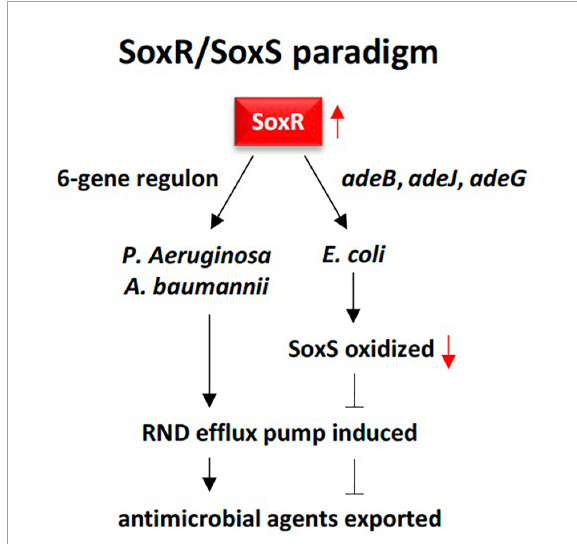
FIGURE8 Demonstration of the RND multidrug efflux system contributed by SoxR response regulator in rhizobiome of M oleifera following two resistance patterns, one in Escherichia coli,